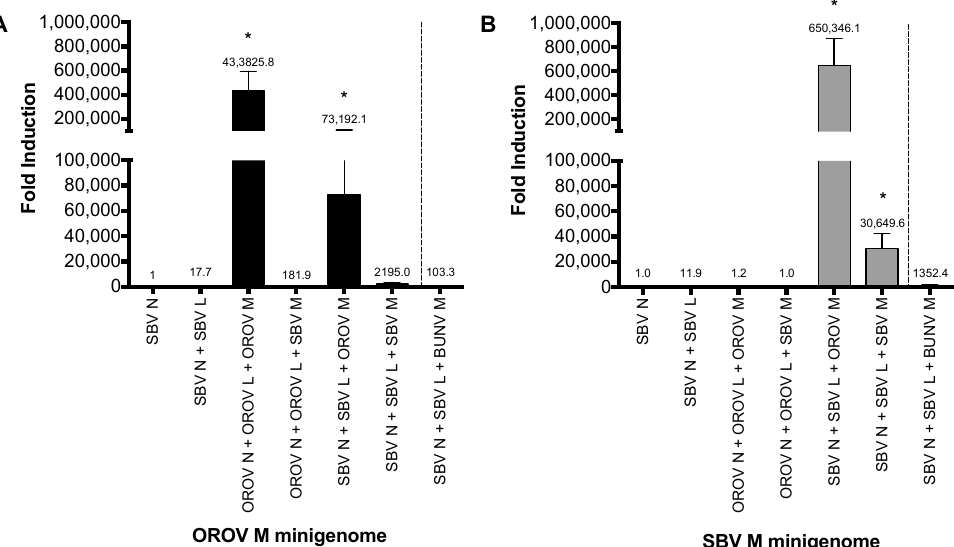
Figure 2. Virus-like particle (VLP) assay. ( A , B ) BSR-T7/5 cells were transfected with pTM1SBV-L (200 ng) and pTM1SBV-N (400 ng) or pTM1OROV-L and pTM1OROV-N (400 ng), along with pTM1-M (200 ng), and M-minigenome (200 ng) and pTM1-FF-Luc (40 ng). At 48 h p.t., clarified supernatant was used to infect cells pre-transfected with protein-expressing plasmids only, as indicated. At 24 h p.t., luciferase readings were measured as described above. Renilla activity is expressed as fold induction over control pTM1-N. Error bars indicate SD ( n = 3). * p < 0.05 (pair-wise Student’s t -test). BUNV, Bunyamwera virus; OROV, Oropouche virus; SBV, Schmallenberg virus; L, viral polymerase; N, nucleocapsid protein; M, glycoprotein precursor; M minigenome, medium segment